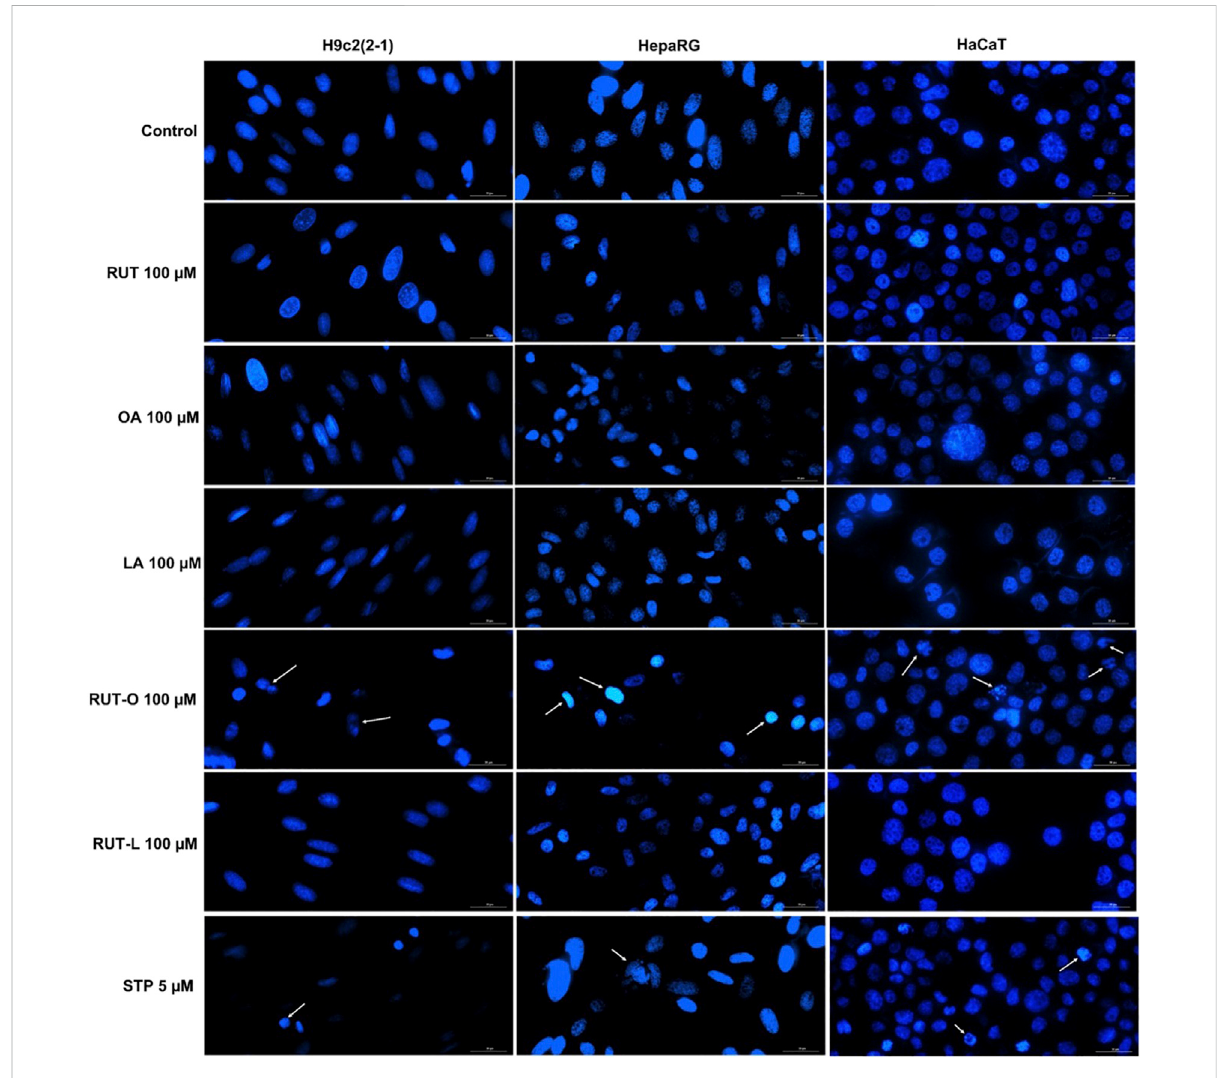
FIGURE 5 Nuclear staining of H9c2(2-1), HepaRG, and HaCaT cells following a 24 h treatment with the parent compounds (RUT, OA, LA) and rutin esters (RUT-O, RUT-L) at 100 µM. Staurosporine (STP) 5 µM was used as positive control for apoptosis. White arrows indicate nuclei presenting an apoptotic-like aspect. The scale bars represent 30